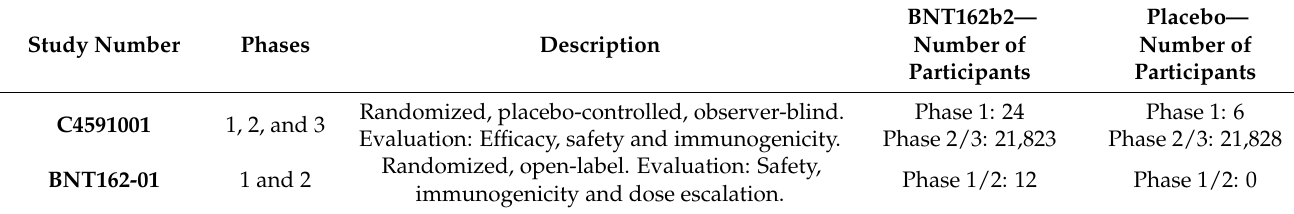
Table 3. Pfizer-BioNTech COVID-19 Vaccine—Study Description [95].